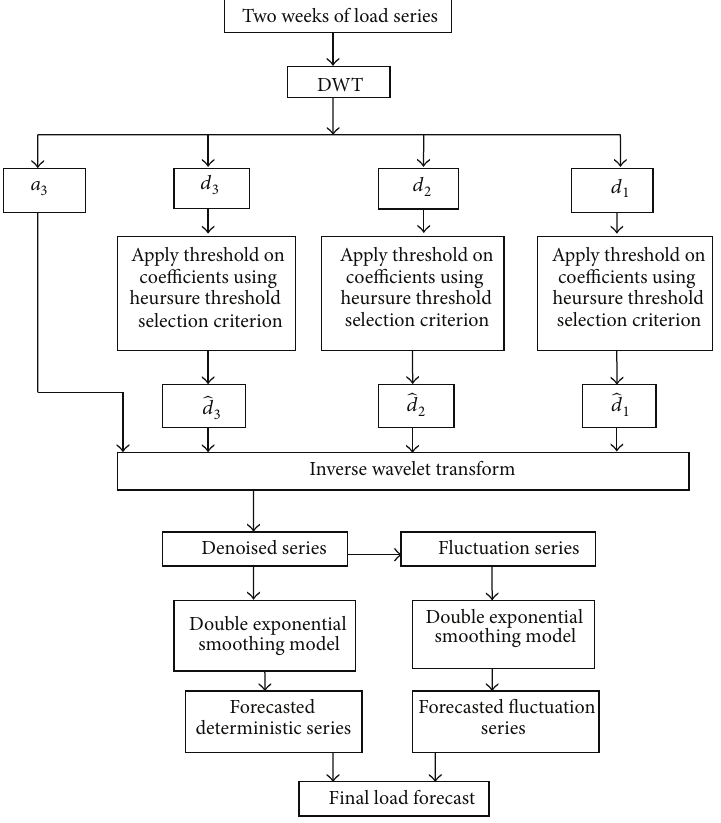
Figure 1: Flow chart of the algorithm.